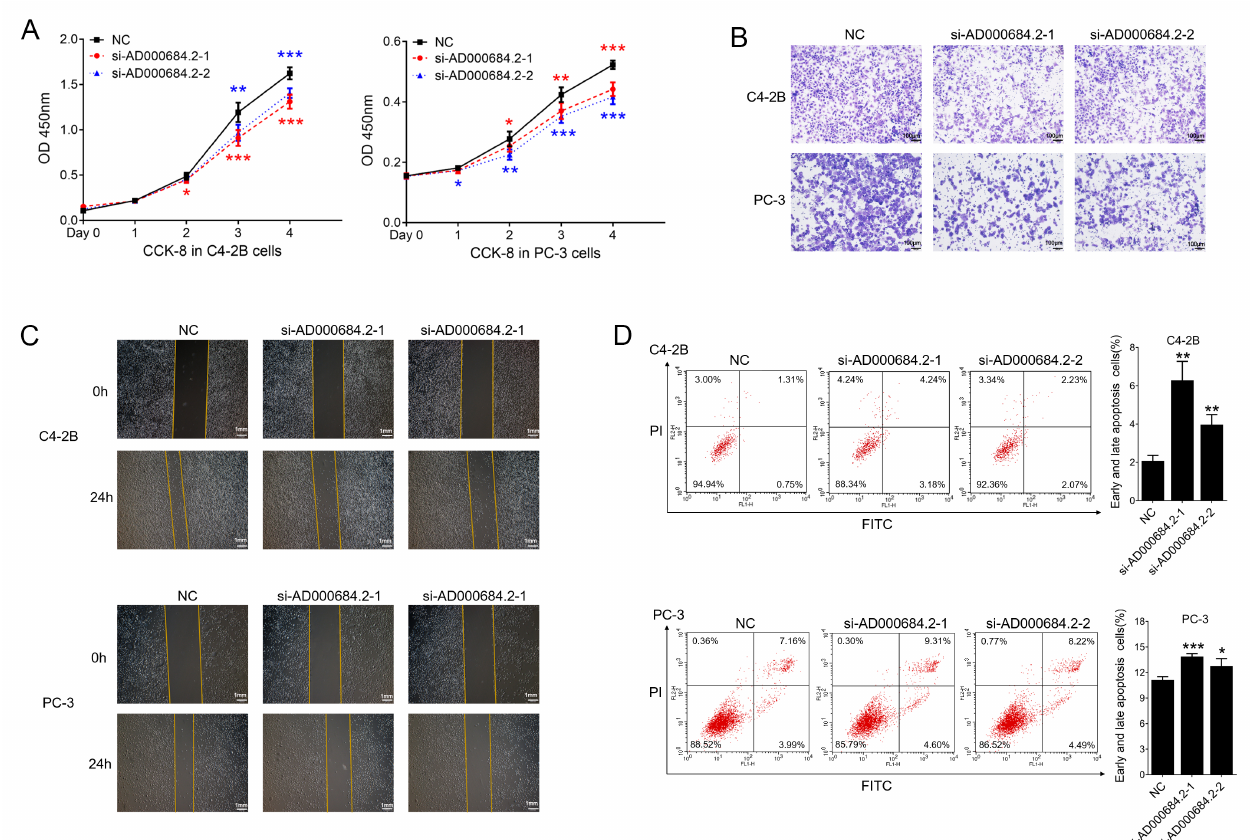
Figure 5. AD000684.2 promotes cell proliferation and motility and inhibits cell apoptosis in PCa cell lines: ( A ) cell proliferation analysis was performed with CCK-8 assay in C4-2B and PC-3 cells. Cells transfected with si-AD000684.2 and siNC were seeded into a 96-well plate at 5000 cells/well and examined at timepoints of 0, 1, 2, 3, and 4 days; ( B ) cell migration assay was performed in C4-2B and PC-3 cells. Cells transfected with si-AD000684.2 and siNC were seeded into a transwell chamber and then stained with 0.1% crystal violet after incubation for 24 h, bar = 100 µ m; ( C ) wound healing assays were performed in C4-2B and PC-3 cells Cells were transfected with si-AD000684.2 and siNC, and scratch healing was observed after 24 h, bar = 100 mm; ( D ) cell apoptosis assay was performed in C4-2B and PC-3 cells. Cells were transfected with si-AD000684.2 and siNC, and then the percentage of early and late apoptotic cells was quantitated by Annexin V/PI staining using FACSCalibur flow cytometry ( A – D , n = 3; data are presented as the mean ± SD; * p < 0.05; ** p < 0.01; *** p < 0.001; ns, not